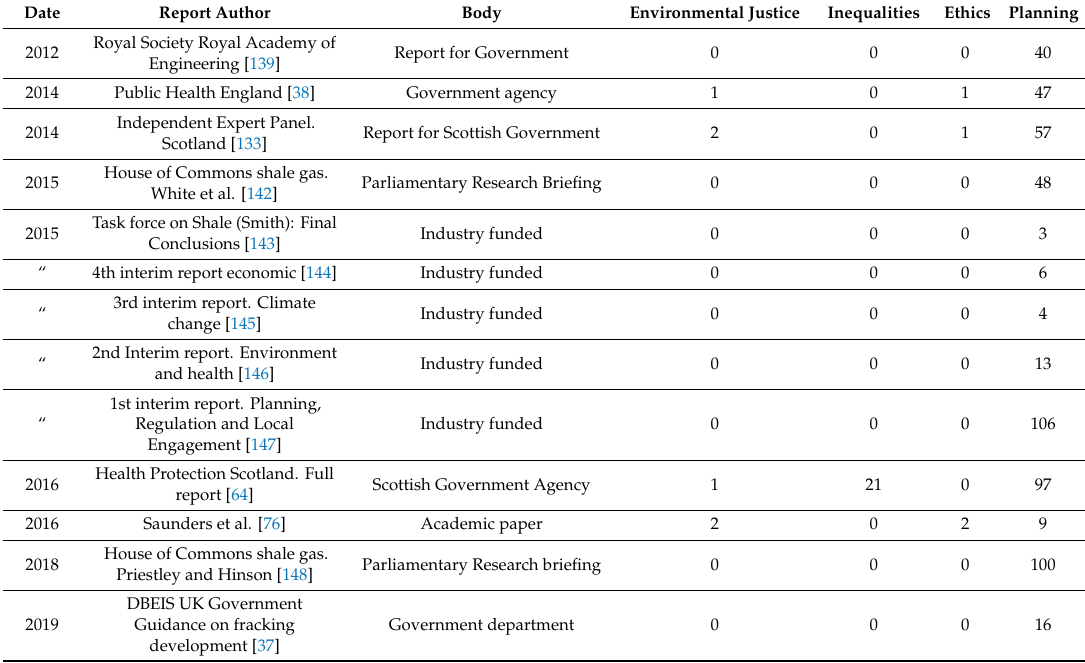
Table 4. Environmental justice, ethics and planning issues cited in UK shale oil and gas reports: number of times these topics are mentioned in the listed papers and